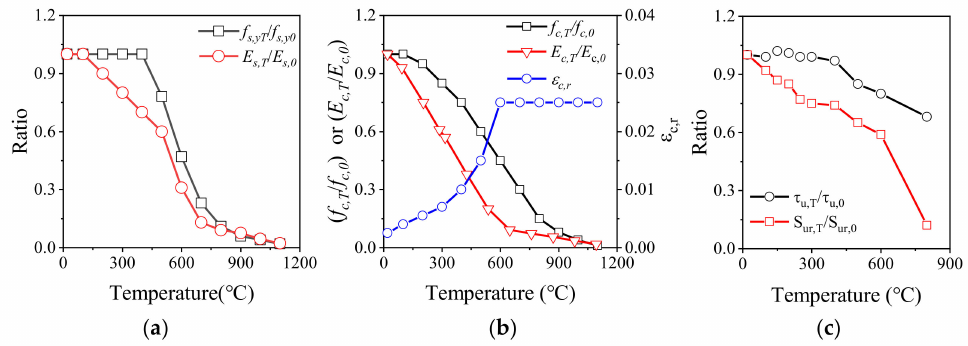
Figure 5. Degradation of mechanical performance of ( a ) reinforcing steel ( b ) concrete and ( c ) bond-slip at high